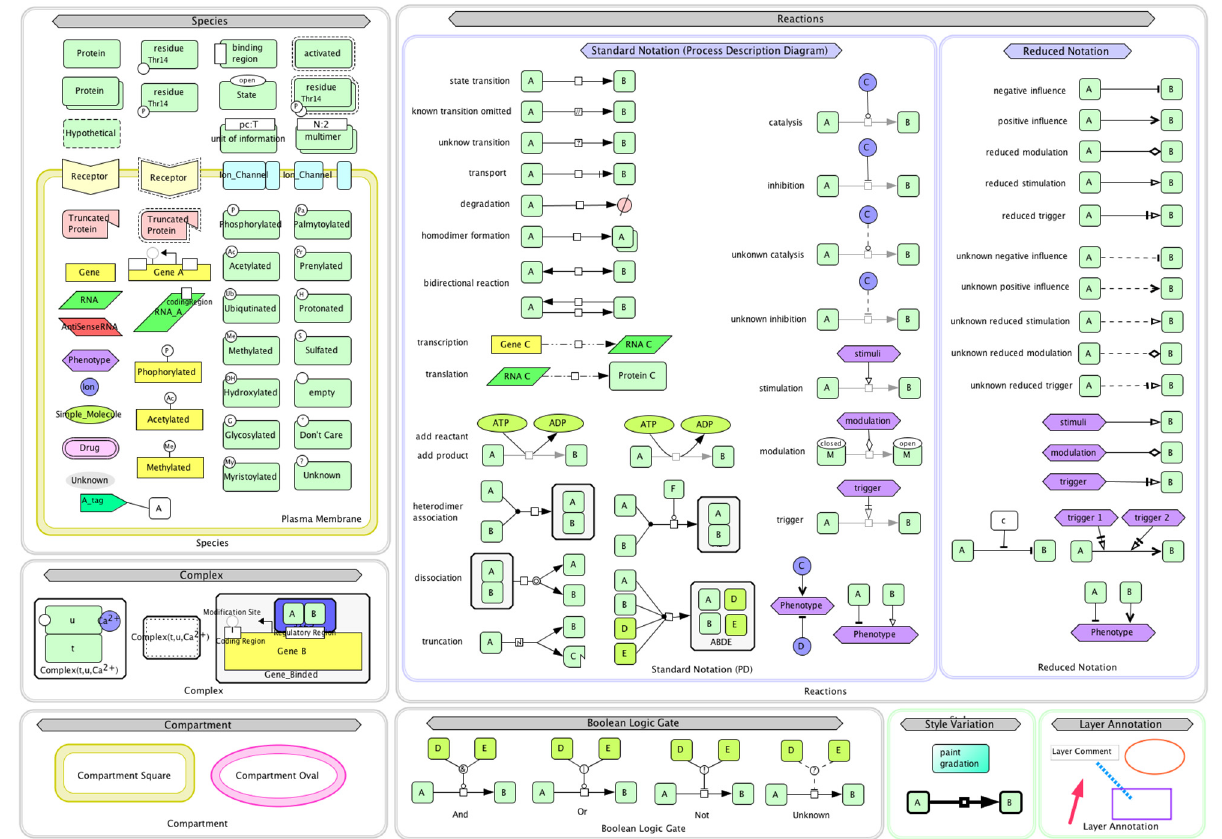
Figure 1. System biology graphical notation (SBGN) symbols used in Cell Designer for modeling of fruiting mechanism in Pleurotus.